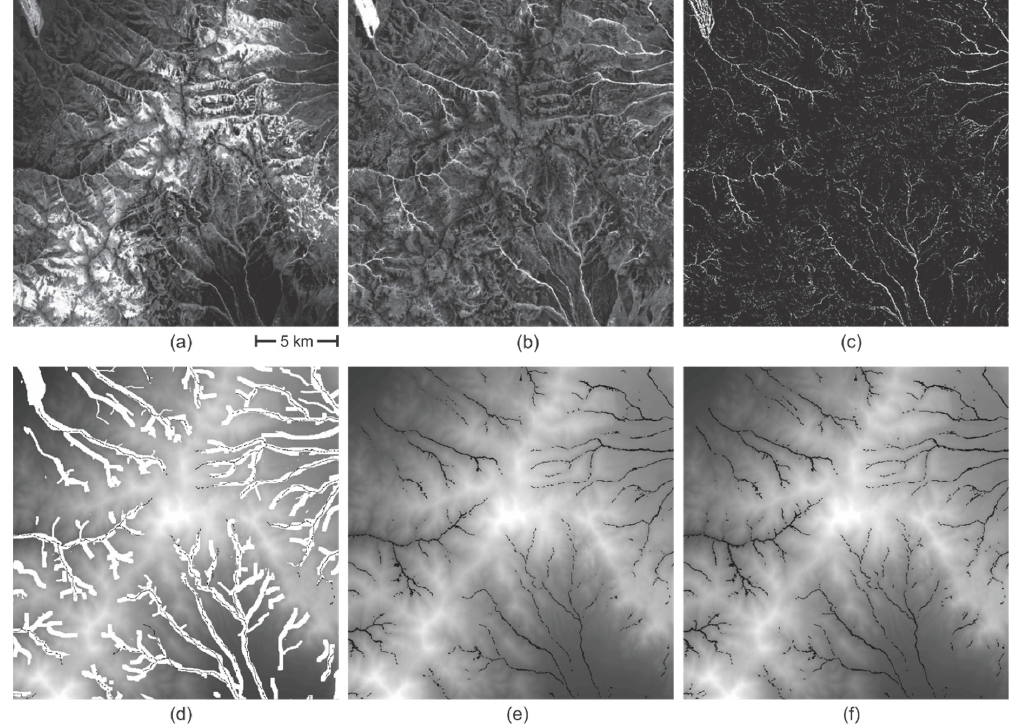
Figure 2. NDVI calculations: ( a ) Original NDVI; ( b ) Anomalies from original NDVI; ( c ) Anomalies from filtered NDVI. Mapped riparian in black on digital elevation model (DEM) background: ( d ) NHDPlus riparian pixels in black, potential riparian mask in white; ( e ) Adding result from original NDVI; ( f ) Adding results from original and filtered NDVI.